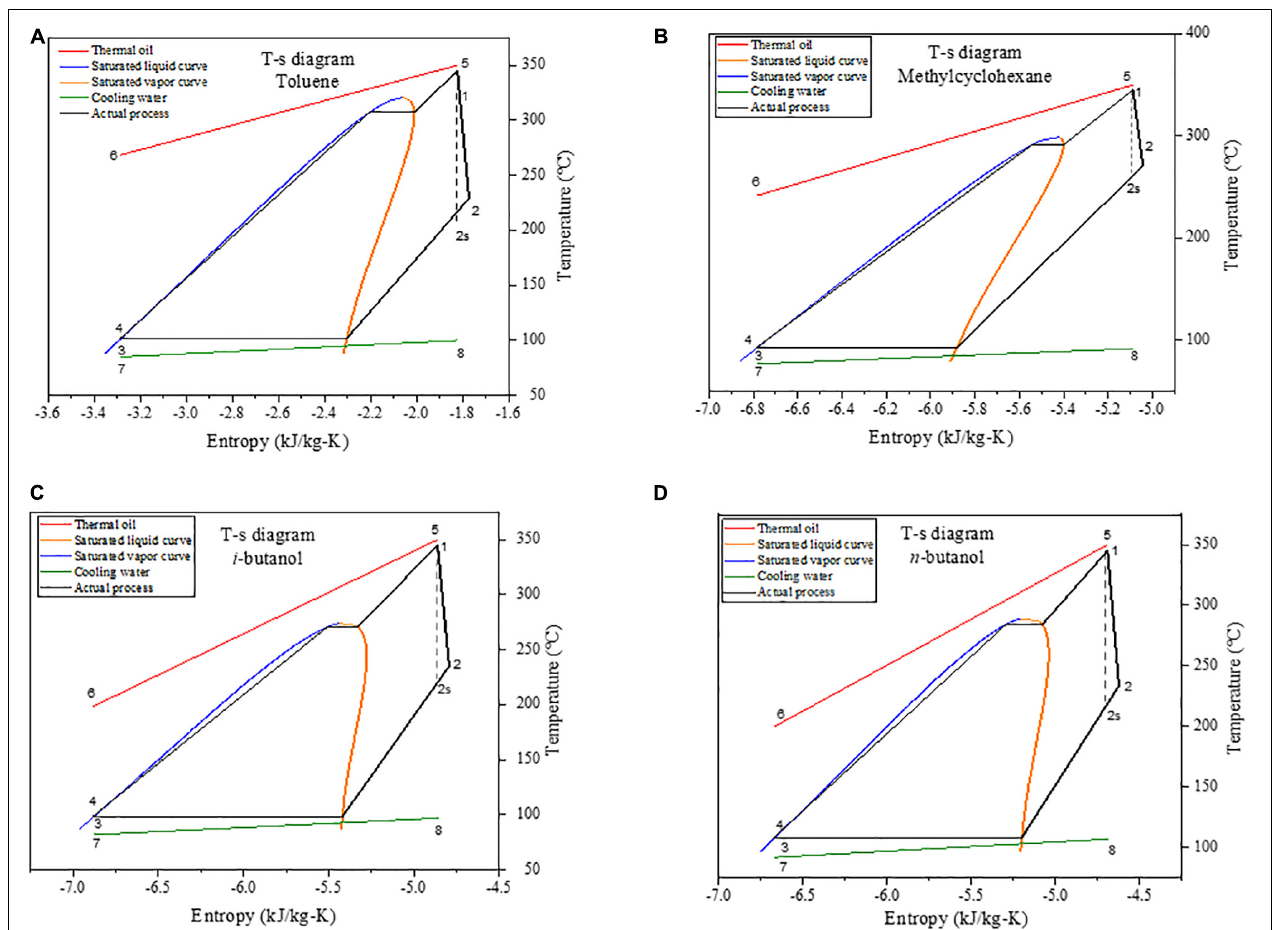
FIGURE 2 | Temperature–entropy diagrams of organic Rankine cycle (ORC) systems using (A) toluene, (B) methylcyclohexane, (C) i -butanol, and (D) n -butanol as the working fluid.